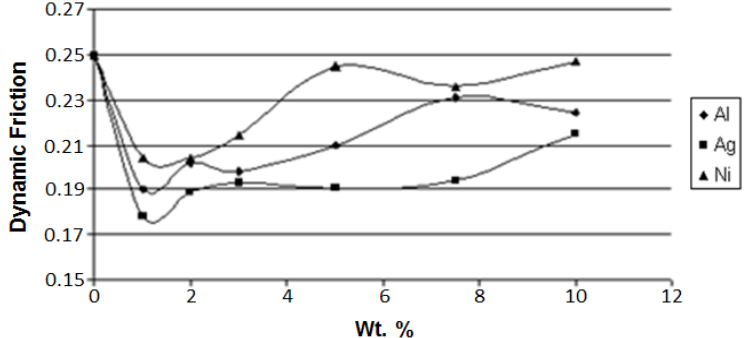
Figure 3. Dynamic friction of the polyethylene (PE)-based composites with metal microfillers against steel as the sliding surface. Reprinted from [10] with permission. Copyright Society of Plastics Engineers, 2008.